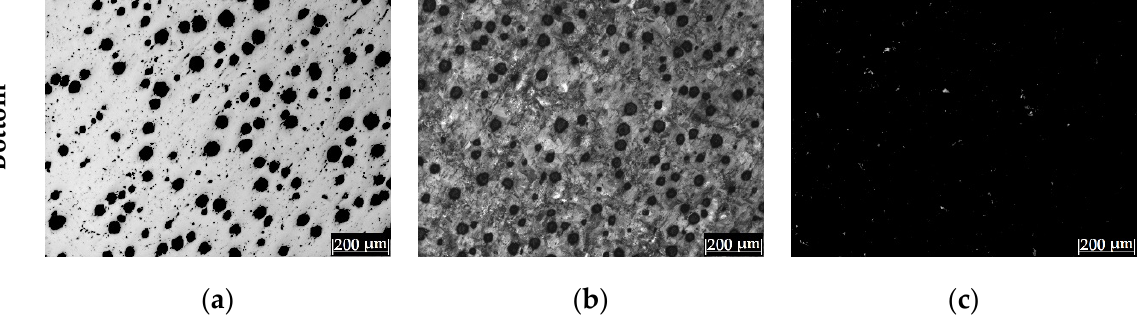
Figure A1. Microstructure of DI-0.2Cr sample for the top, middle, and bottom zones for ( a ) as-cast, ( b ) etched with nital, and ( c ) etched with ammonium persulfate conditions. Top Middle Bottom